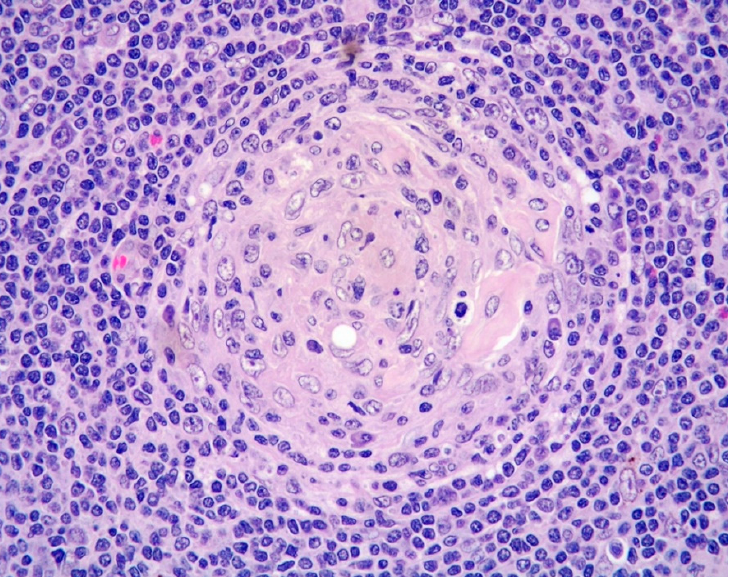
Figure 3. Hyalinized germinal centers with penetrating venules characteristic of Castleman disease (HE, 400× magnification).